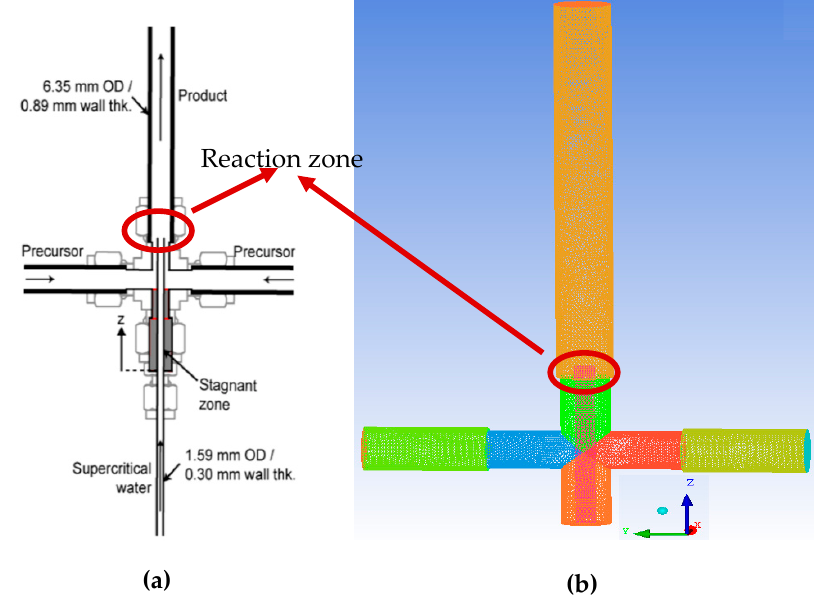
Figure 2. Cross-sectional diagrams of the confined jet mixer (CJHM) where ( a ) schematic diagrams of the CJM reactor used in the experiment and ( b ) computational domain of the CJM reactor.